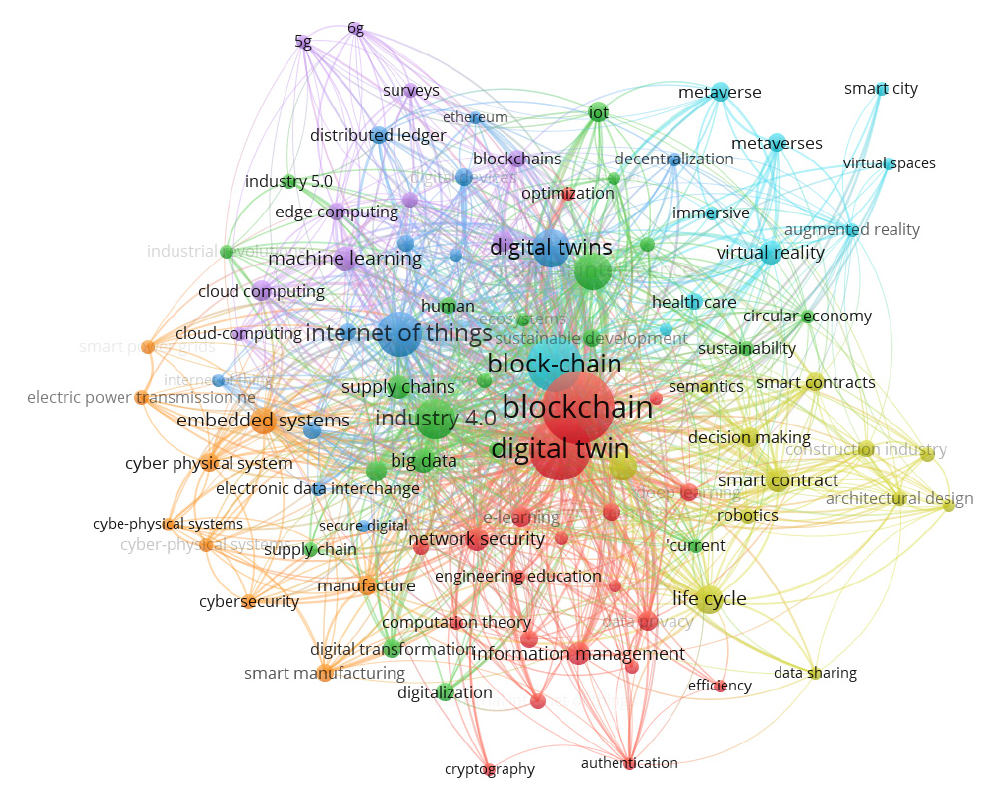
Figure 10. Keyword network for “blockchain,” “digital,” and “twin.”